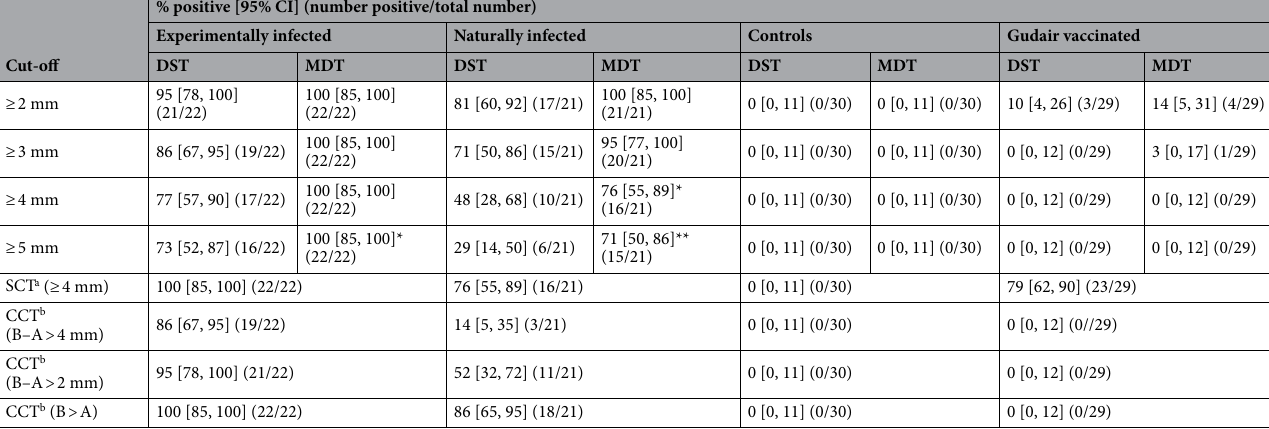
Table 2. Comparison of skin test results at defined cut-off values. DST DIVA skin test, MDT molecularly defined tuberculin. * p < 0.05, ** p < 0.01 McNemar test (compared to DST). a SCT, Single Cervical Tuberculin skin test interpretation (skin reaction increase ≥ 4 mm on PPD-B site). b CCT, Comparative Cervical Tuberculin skin test interpretation (skin reaction increases for PPD-B minus PPD-A (B–A) at different